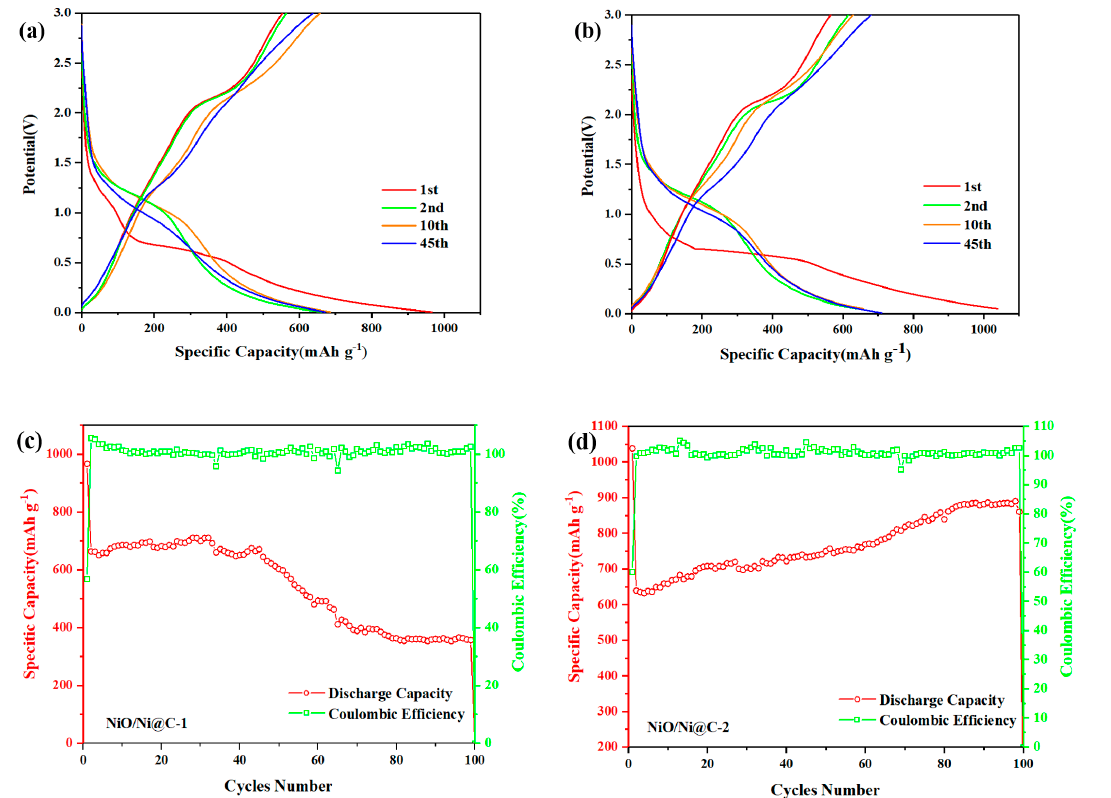
Figure 4. Galvanostatic discharge/charge voltage profiles of NiO/Ni@C-1 ( a ) and NiO/Ni@C-2 ( b ) for the inchoate two cycles, the 10th and 45th cycles between 0.01 and 3.00 V at a current density of 0.1 mA g − 1 . Capacity vs cycle number and the corresponding coulombic efficiency of NiO/Ni@C-1 ( c ) and NiO/Ni@C-2 ( d ) at 0.1 A g − 1 for 100 cycles.